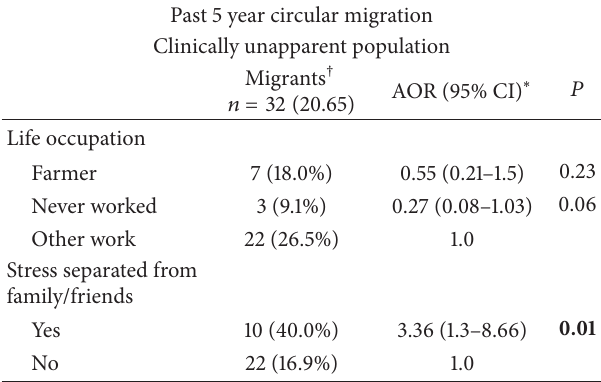
Table 5: Multivariate analysis of factors associated with past 5 year circular migration among migrants diagnosed with leprosy compared to non-migrant residents with leprosy.